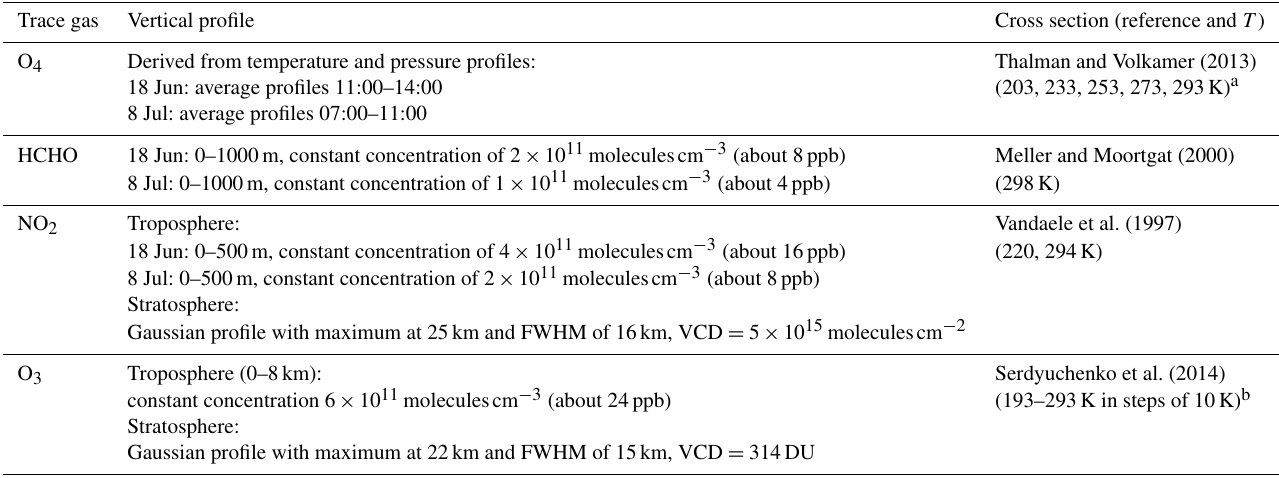
Table A3. Trace gas profiles and cross sections used for the simulation of the synthetic spectra. Trace gas